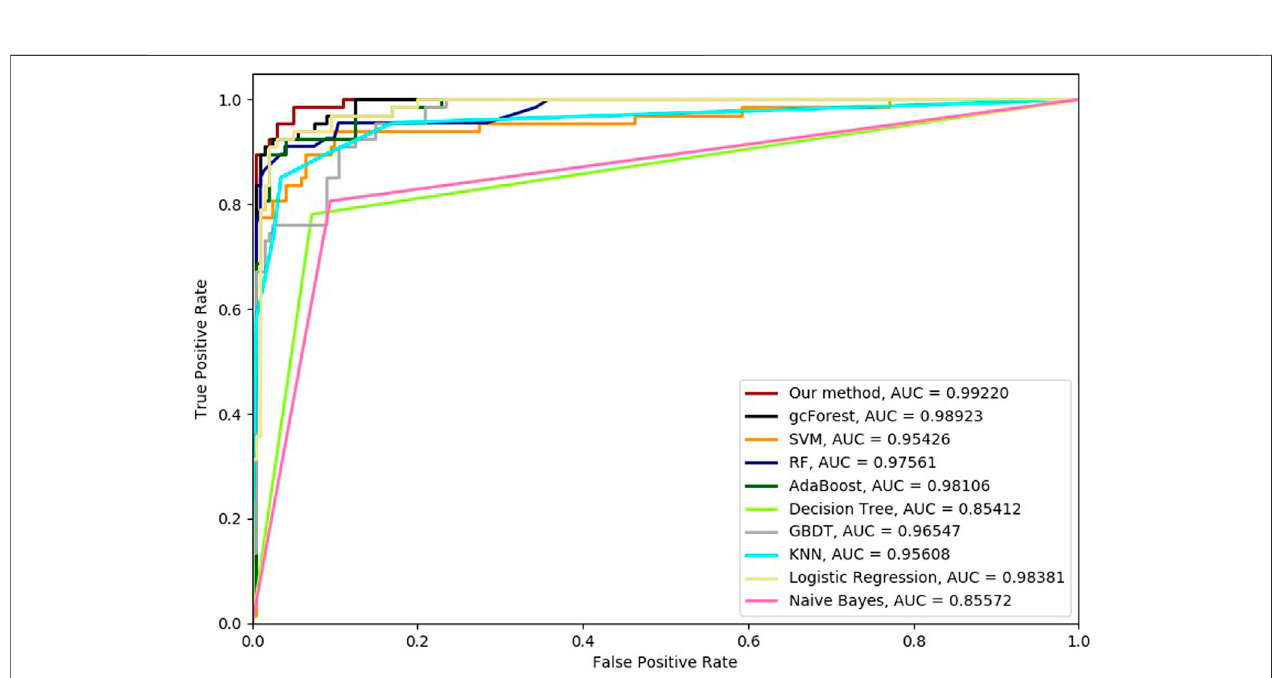
FIGURE 5 | Hypertension-related compound identi fi cation performances of ten methods with 4-cross validation methods.